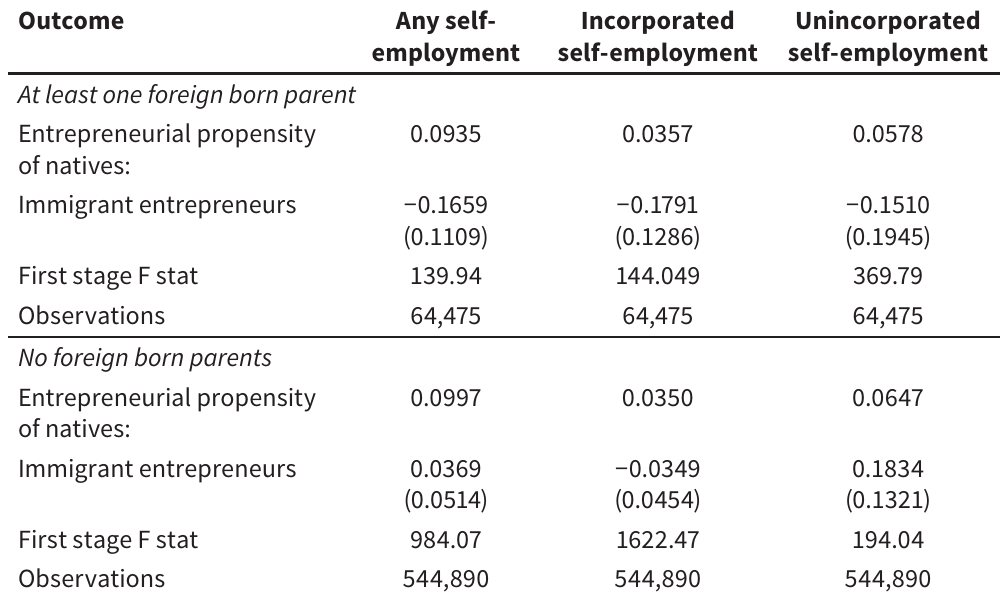
Table A13 Heterogeneity in the Impact of Immigrant Entrepreneurs across Natives by Parents’ Origin: TSLS